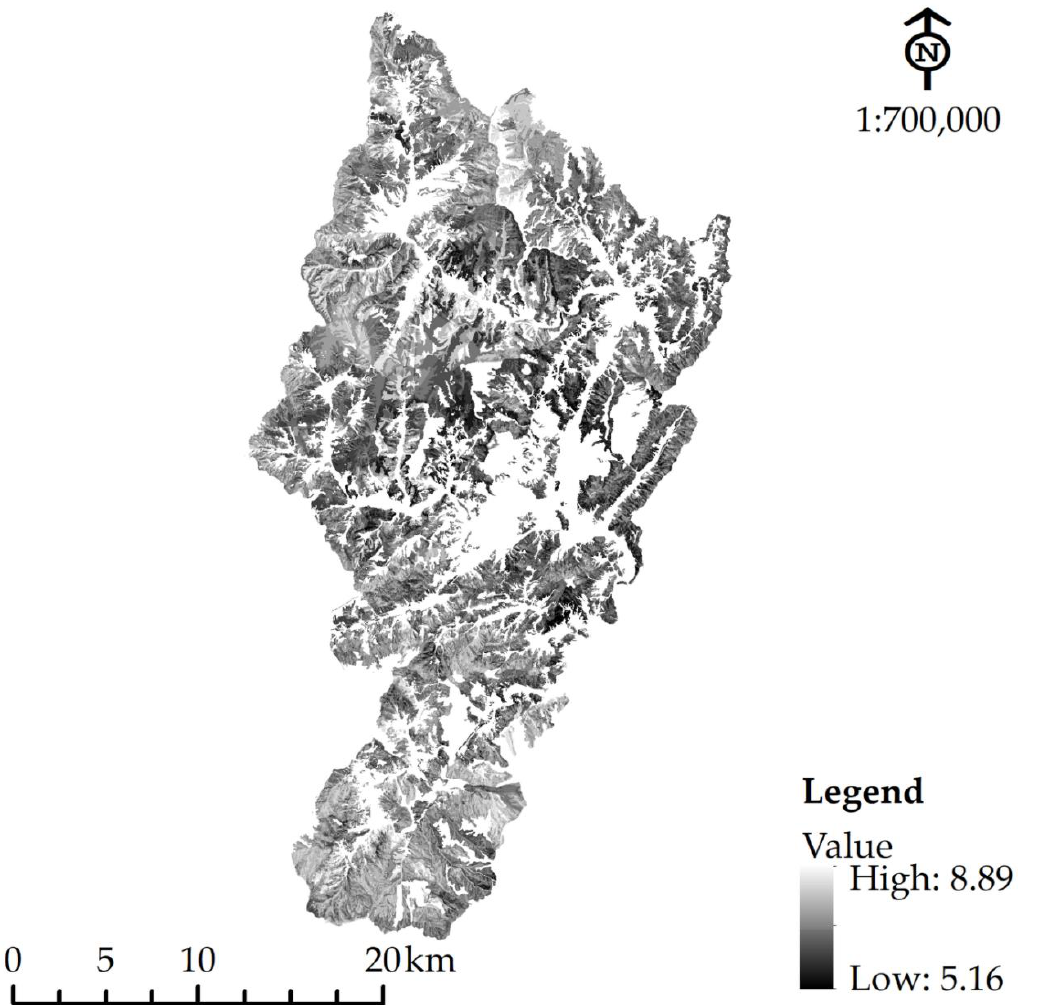
Figure 6. Primary data calculated by assigning weights to detailed criteria for each growth factor of WSG.